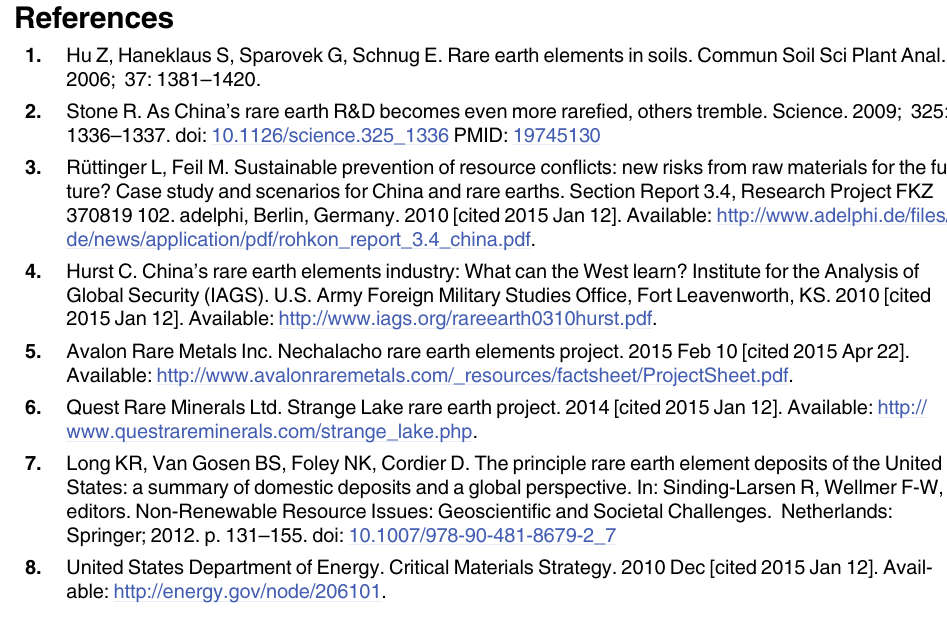
S3 Table. Summary of ANOVA or Kruskal-Wallis analyses on aboveground, shoot biomass (and including the radish bulb for R . sativus ) for five plant species grown in rare earth ele- ment (REE) contaminated soils. No observed effect (NOEC) and lowest observed effect (LOEC) concentrations of the given REE were determined based on either Dunnett's one-way post hoc comparisons (ANOVA) or Conover-Inman post hoc comparisons (Kruskal-Wallis) for negative differences (i.e. reduced biomass) from the controls. S4 Table. ANOVA (or Kruskal-Wallis) results for root biomass for five plant species tested in rare earth element (REE) contaminated soils. Only the control, 2 nd , 4 th , and 6 th doses for each REE were included. Dunnett's one-way post hoc comparison (or the Conover-Inman test) was used to determine doses that were significantly negatively different from the controls. S5 Table. Root:soil and shoot:soil ratios based on detected rare earth element (REE) con- centrations in dosed soils as well as in the roots and shoots of the five tested plant species.